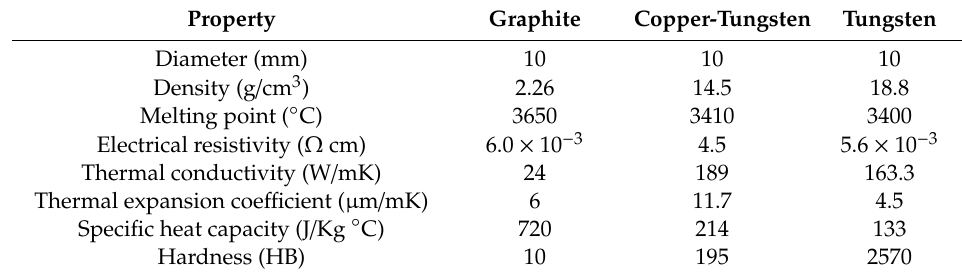
Table 1. Properties of Graphite, Copper-Tungsten and Tungsten electrodes.